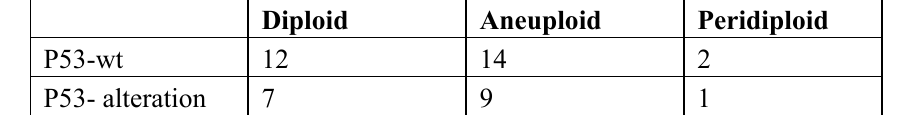
Table 3. Presence of p53 mutations in sarcomas (n = 44) as related to the ploidy-status.